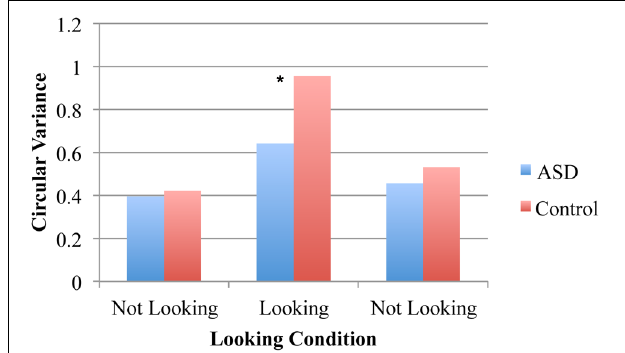
FIGURE 2 | Circular variance for spontaneous coordination conditions. No entrainment occurred during the two “not looking” conditions but spontaneous phase entrainment was evident in all pairs during the looking condition (i.e., when participants looked at the partner’s pendulum). Overall less phase entrainment was displayed during the looking condition in the ASD pairs than the control pairs ( ∗ p =